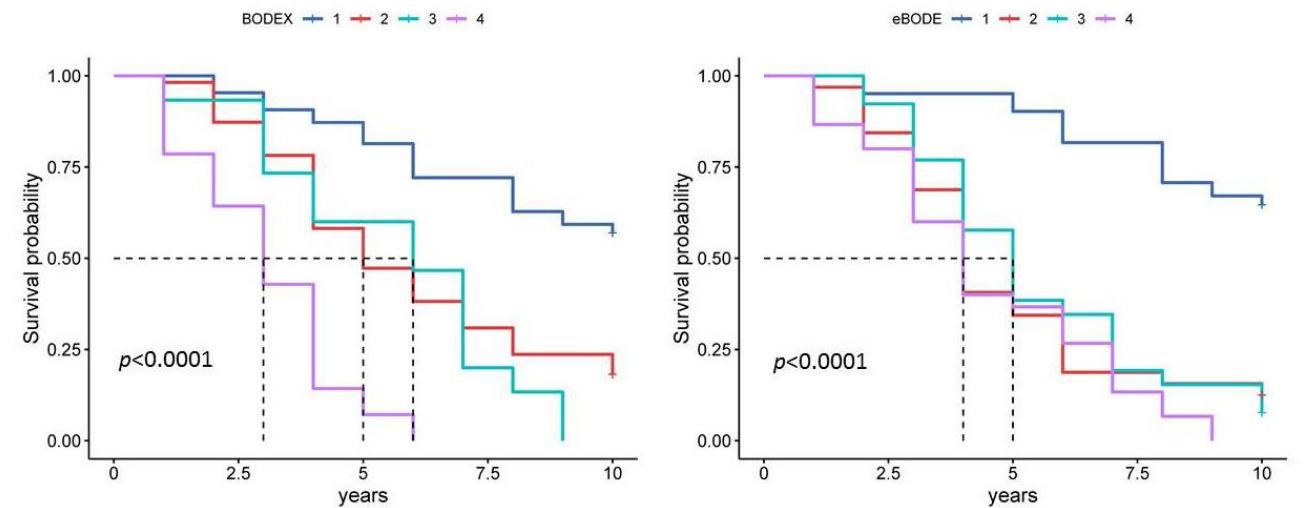
Figure 5. Kaplan–Meier curve plot for the BODEX index and the eBODE index in estimating 10-year survival. Notes: For the BODEX index, quartile 1 is a score of 0 to 2, quartile 2 is a score of 3 to 4, quartile 3 is a score of 5 to 6 and quartile 4 is a score of 7 to 9. For the eBODE index, quartile 1 is a score of 0 to 2, quartile 2 is a score of 3 to 4, quartile 3 is a score of 5 to 6 and quartile 4 is a score of 7 to 12.